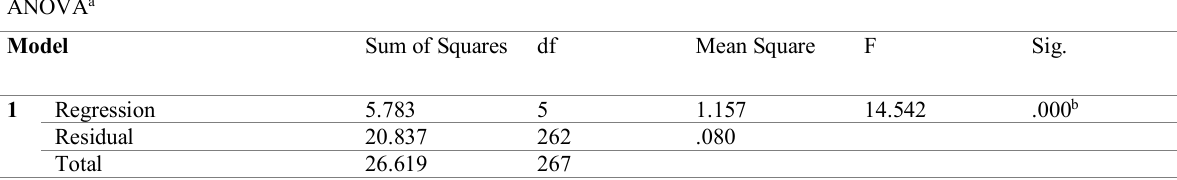
Table 15: Regression ANOVA for continuous quality